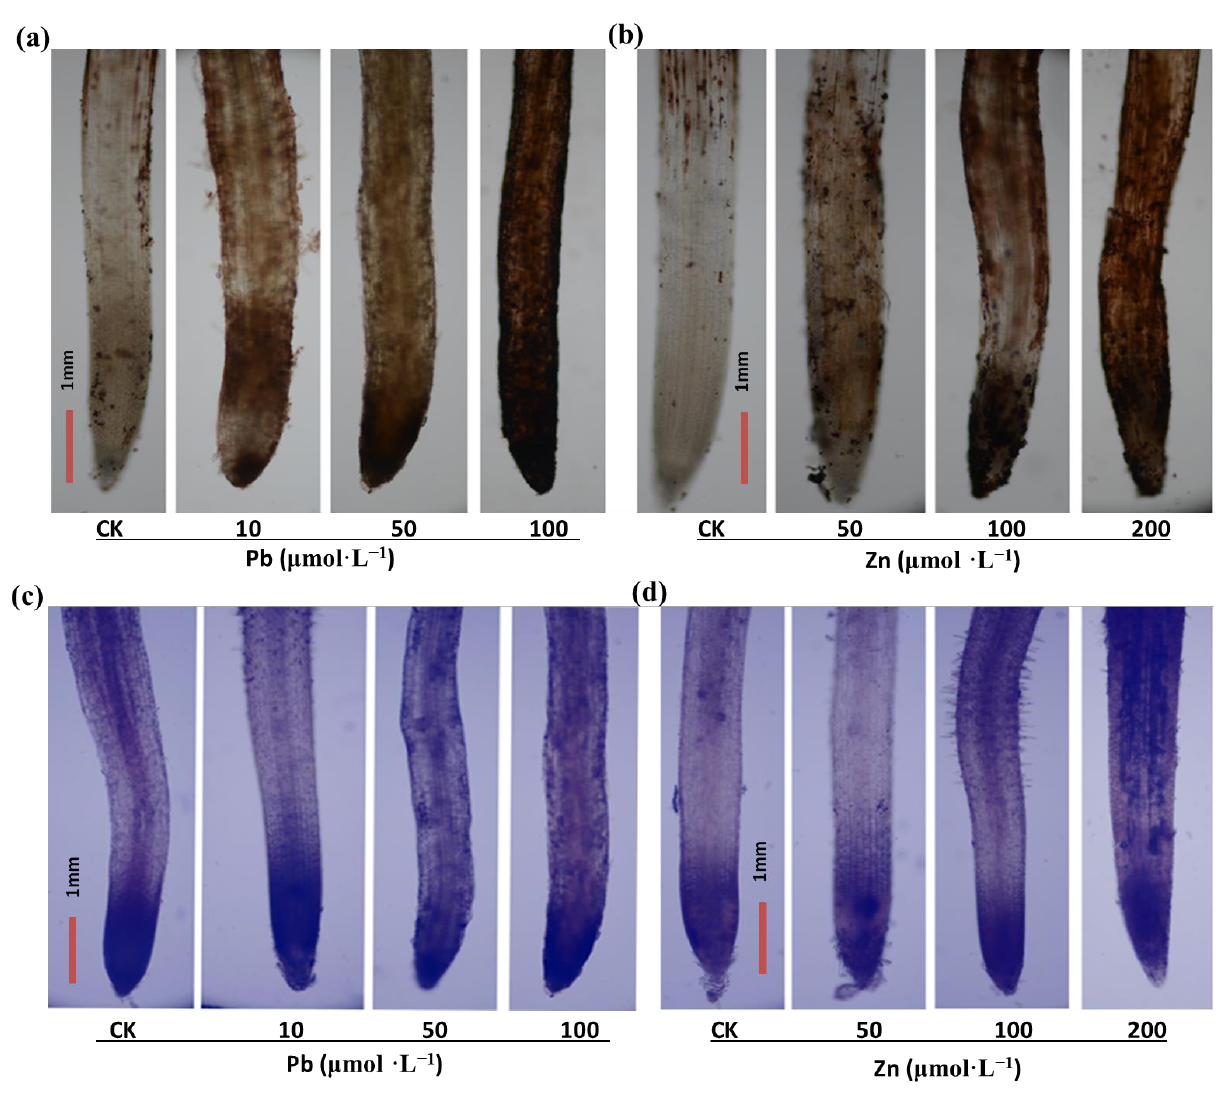
Figure 3. DAB and NBT staining of H 2 O 2 ( a , b ) and O 2 − ( c , d ) in roots of M. cordata grown hydroponi- cally under control (CK) and varied concentrations of Pb and Zn for seven days. Bar, 1 mm. Staining experiments were repeated at least five times with similar